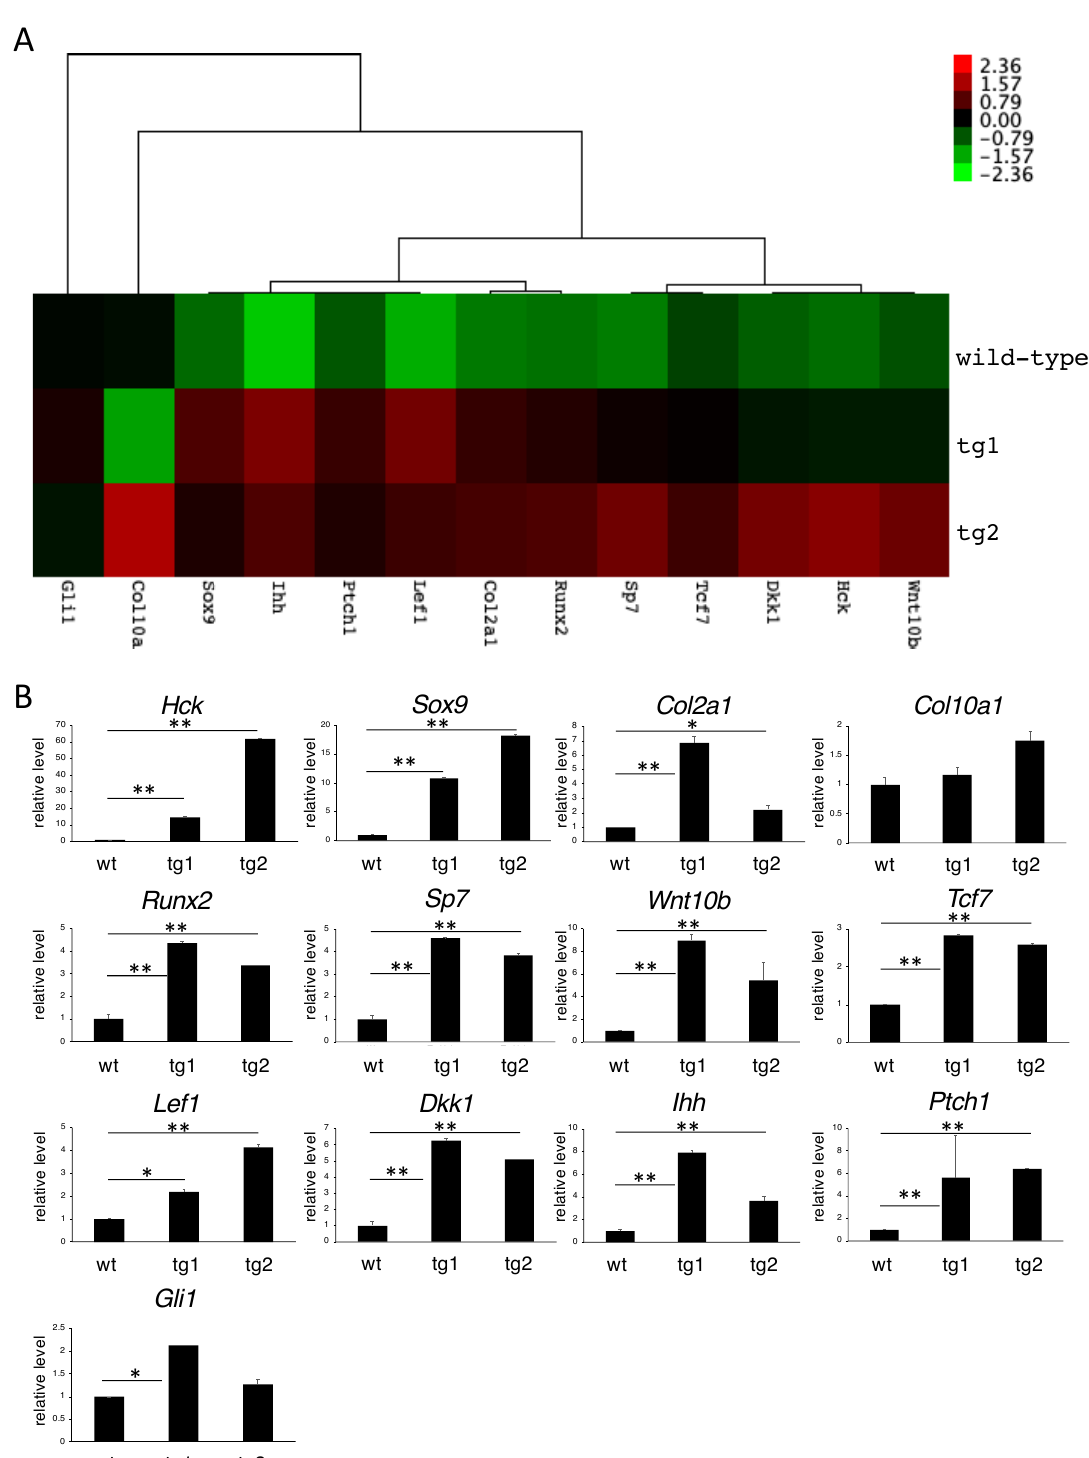
Figure 7. Heatmap and real-time RT-PCR analysis of the selected genes. ( A ) Heatmap of the selected genes. ( B ) Real-time RT-PCR analysis of the selected genes was performed using the same RNA samples used for microarray. The values in wild-type (wt) embryos were defined as 1, and relative levels are shown. All quantitative data were obtained from three independent experiments and the means ± SD are shown. Versus wild-type sample, * p < 0.05, ** p <